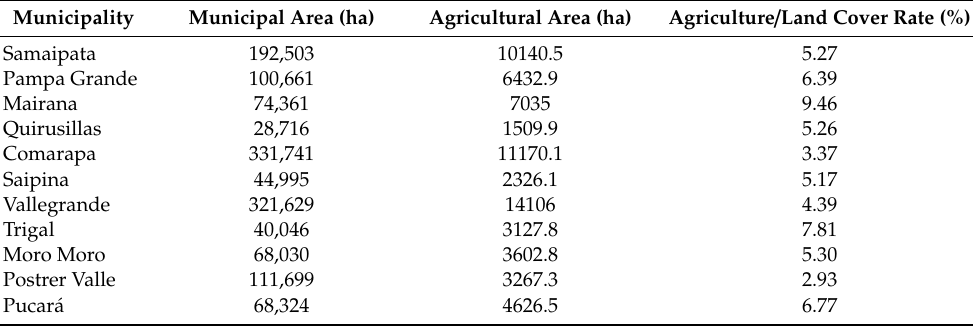
Table 7. Agricultural areas in the di ff erent municipalities of the study